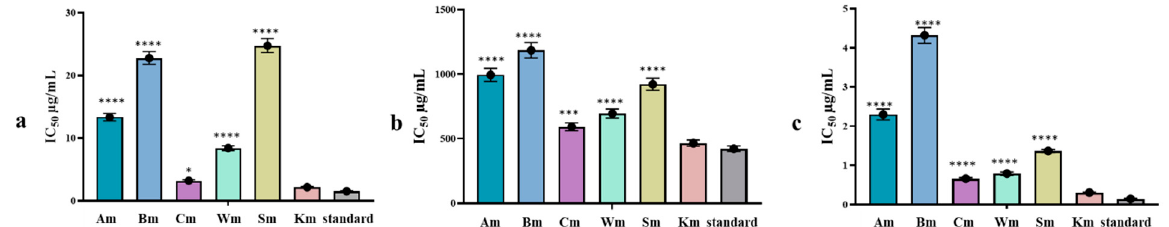
Figure 3. ( a ) Hyaluronidase, ( b ) collagenase, and ( c ) elastase inhibitory activity of C. reticulata leaf essential oil cultivar. The results are expressed as the mean ± SD, n = 3. Asterisks indicate significant differences from the standard drug (*, ***, ****, p < 0.05, p < 0.0009, p <